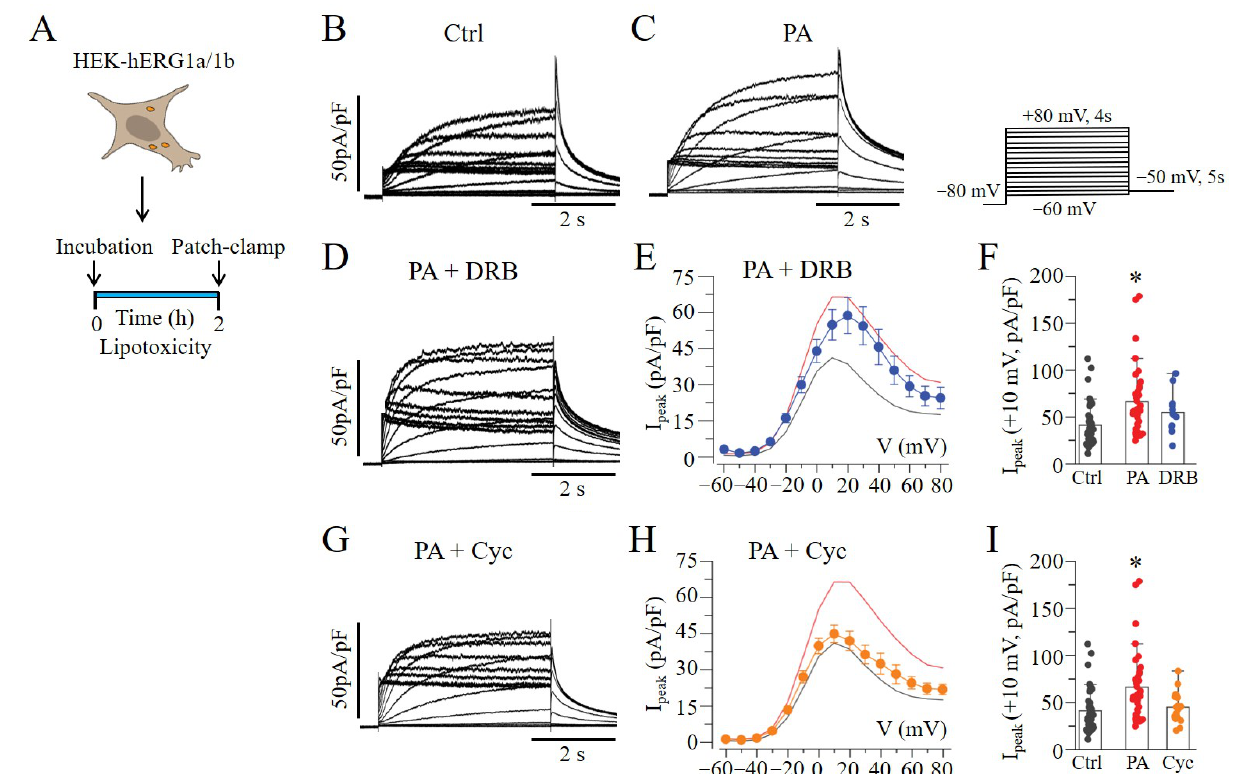
Figure 4. Protein translation contributes to lipotoxicity-induced increase in hERG1a/1b. ( A ) Ex- perimental protocol: macroscopic hERG1a/1b currents were measured in HEK293 cells under control conditions ( B ) and after pre-exposure to lipotoxicity ( C ) for 2 h, using the illustrated voltage protocol. ( D – I ) Exemplar traces, pooled I peak – V curves, and averaged current amplitude measured at +10 mV under the effects of DRB ( , and blue line ) and Cyc ( , and orange line ). The I peak – V curves for hERG1a/1b currents measured in control cells ( black line in E and H ) and in cells pre-treated with lipotoxicity ( red line in E and H ) are shown for comparison. (* statistical signifi- cance at p < 0.05).